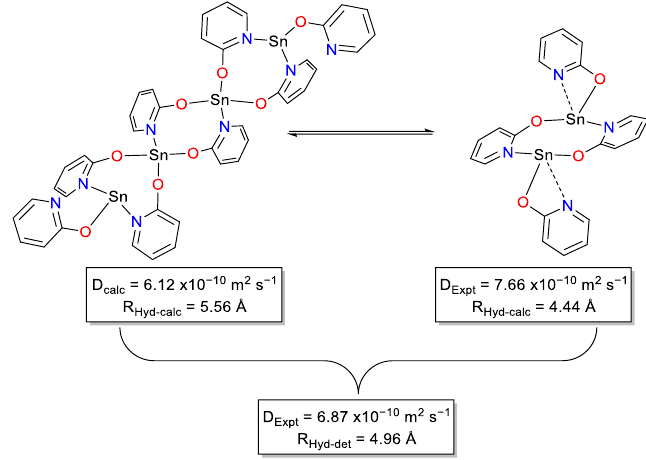
Scheme 2. Proposed Tetramer Dimer equilibria observed for 2 .